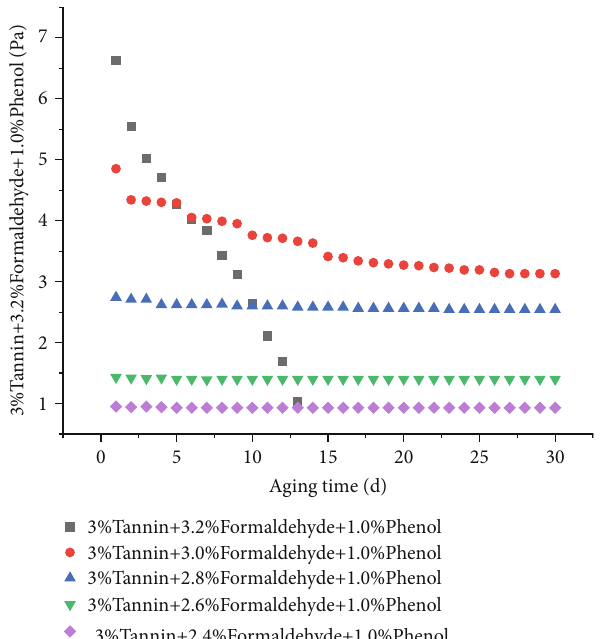
Figure 17: Change trend of gel strength with aging